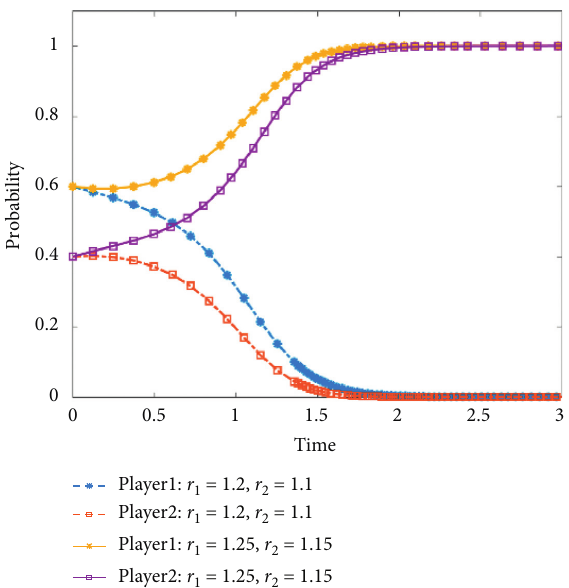
Figure 10: Evolutionary game phase diagram of the system (when r and r improve). 1 2